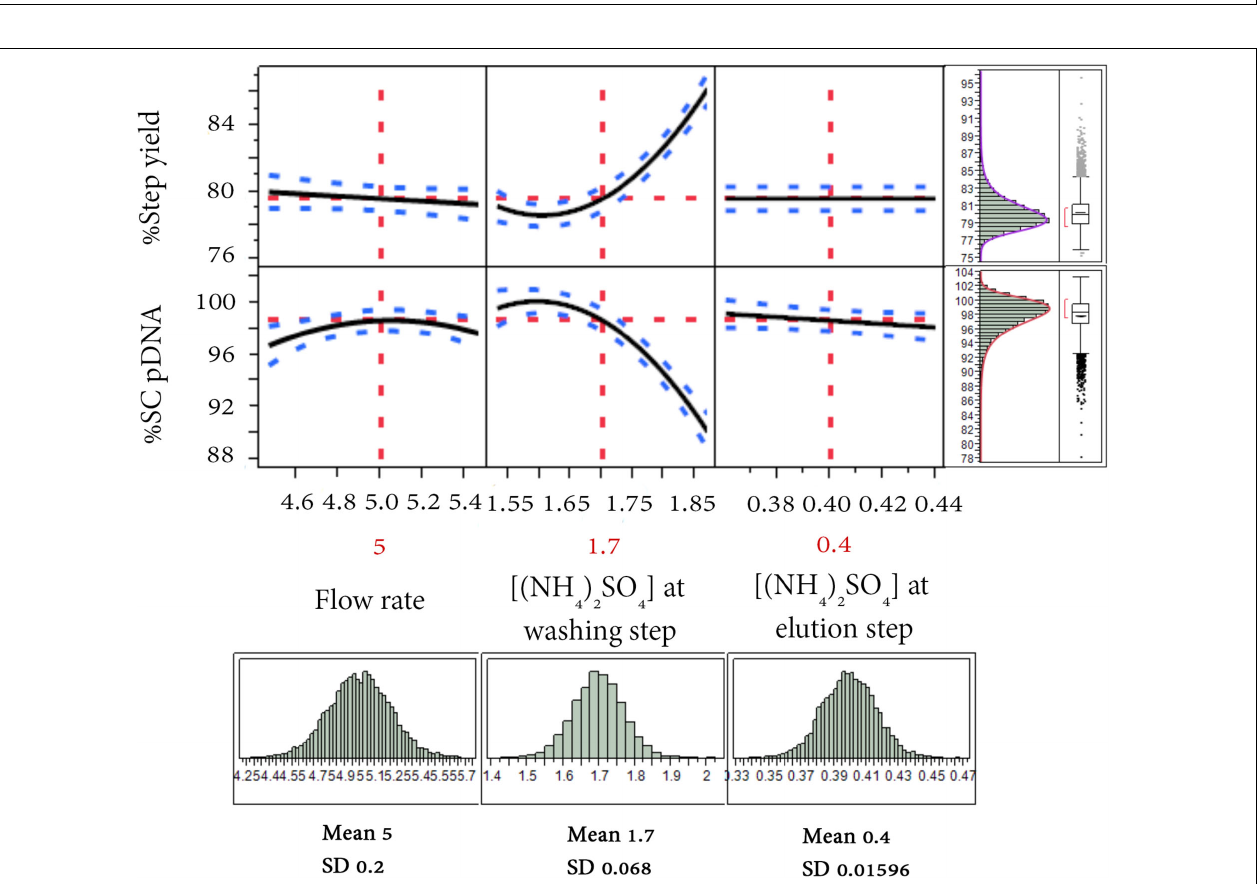
FIGURE 6 | Simulation runs and distribution charts for HIC purification step. The solid lines are the predicted model. The red dashed lines are the interaction plots and the blue dashed lines are the confidence interval.